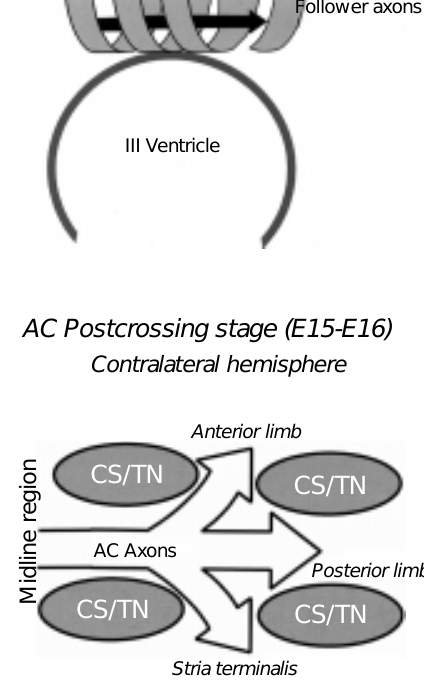
Figure 2 - Schematic representa- tion of the molecular tunnel pres- ent in the midline region rostral to the third ventricle of the brain. Axons that course along the cen- tral portion of the anterior com- missure (AC) bundle may ad- vance at a faster rate (pioneer axons), while those at the mar- gins of the tunnel may elongate more slowly (follower axons) due to their closer contact with the molecular components of the tunnel “wall”. CSPG, Chon-